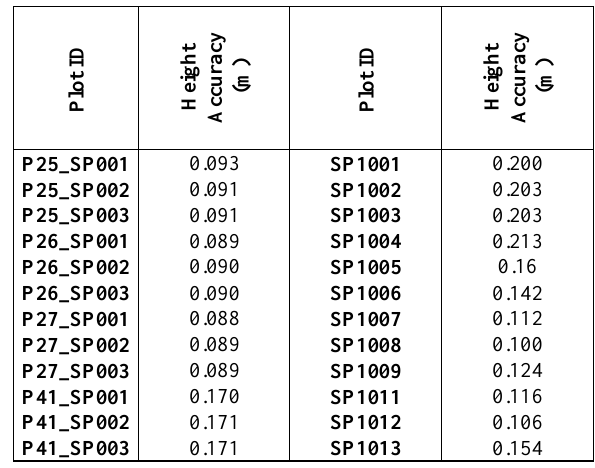
Table 2. Average height accuracy for the ground-truth points of each plot